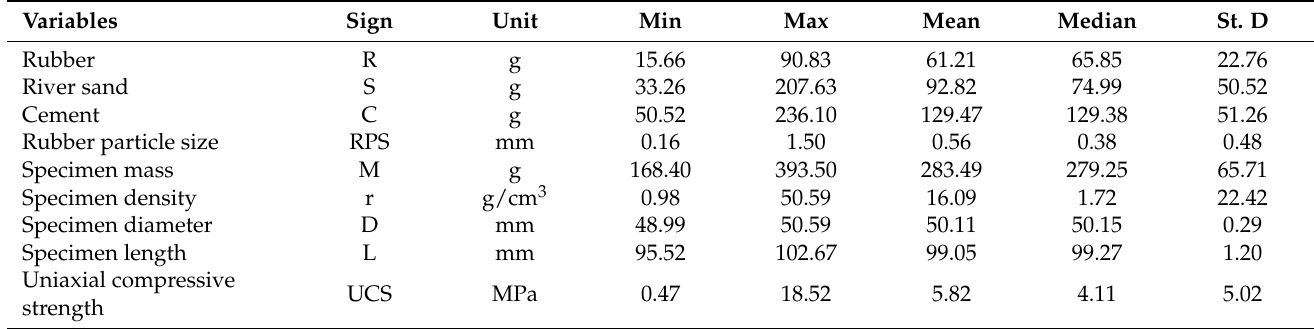
Figure 1. The performance test diagrams of the novel aseismic rubber-concrete material. Table 3. The detailed description of all considered parameters for the UCS prediction. Table 2. Mix proportions of the rubber-concrete material.